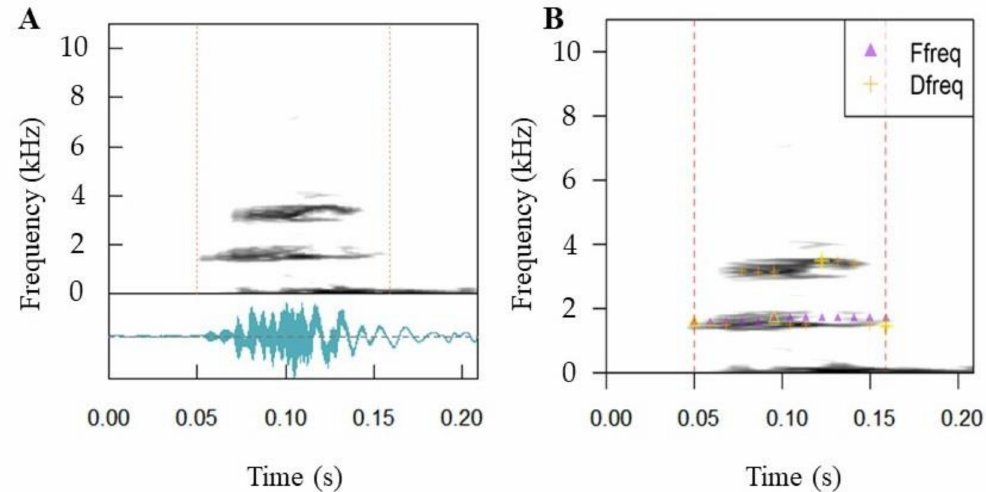
Figure 7. Spectral call properties for Dryophytes suweonensis , recorded in Mundeok, DPR Korea, in May 2018. ( A ) Spectro- gram with oscillogram underneath a representative call of D. suweonensis. The spectrogram highlights the call between the orange vertical dashed lines. ( B ) Frequency tracking of the same D. suweonensis call. Calls detected are highlighted between red dashed lines. Fundamental frequency measurements are shown as purple triangles and dominant frequency measurements as yellow crosses.